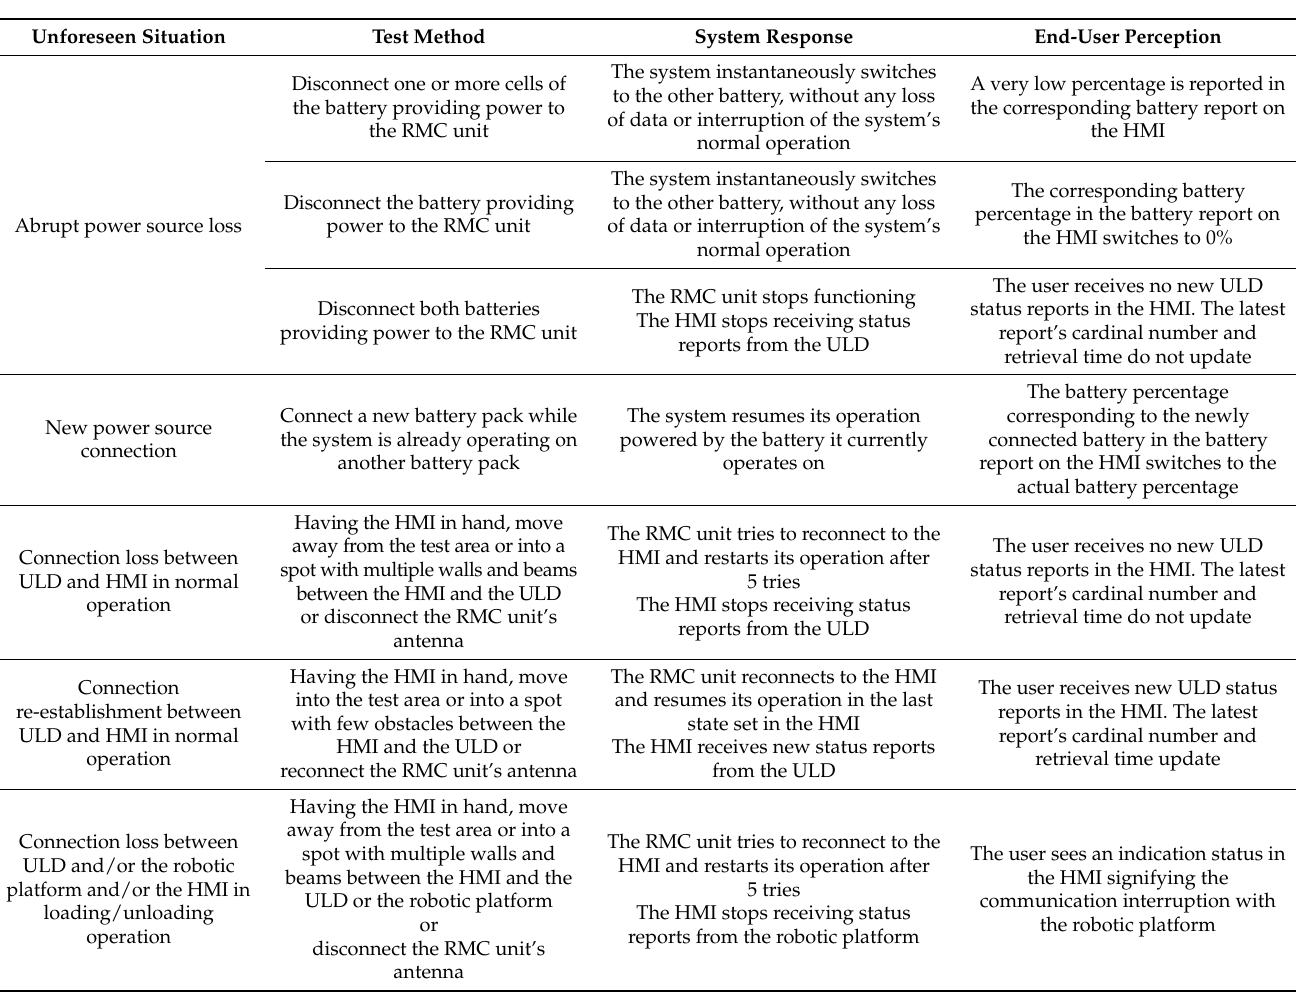
Table 3. Test cases for the system’s response to unforeseen